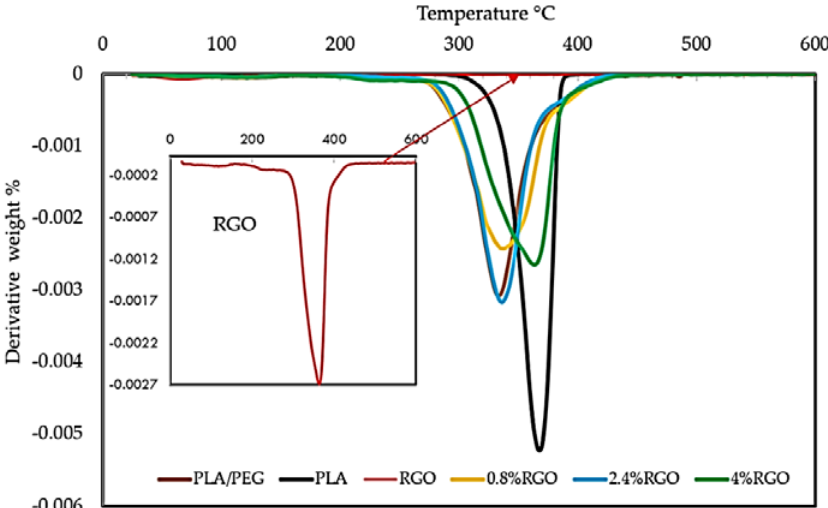
Figure 10. Derivative thermogravimetric (DTG) curves to study the effect of different additions of RGO nanoparticles on the thermal stability of the PLA/PEG mixture.